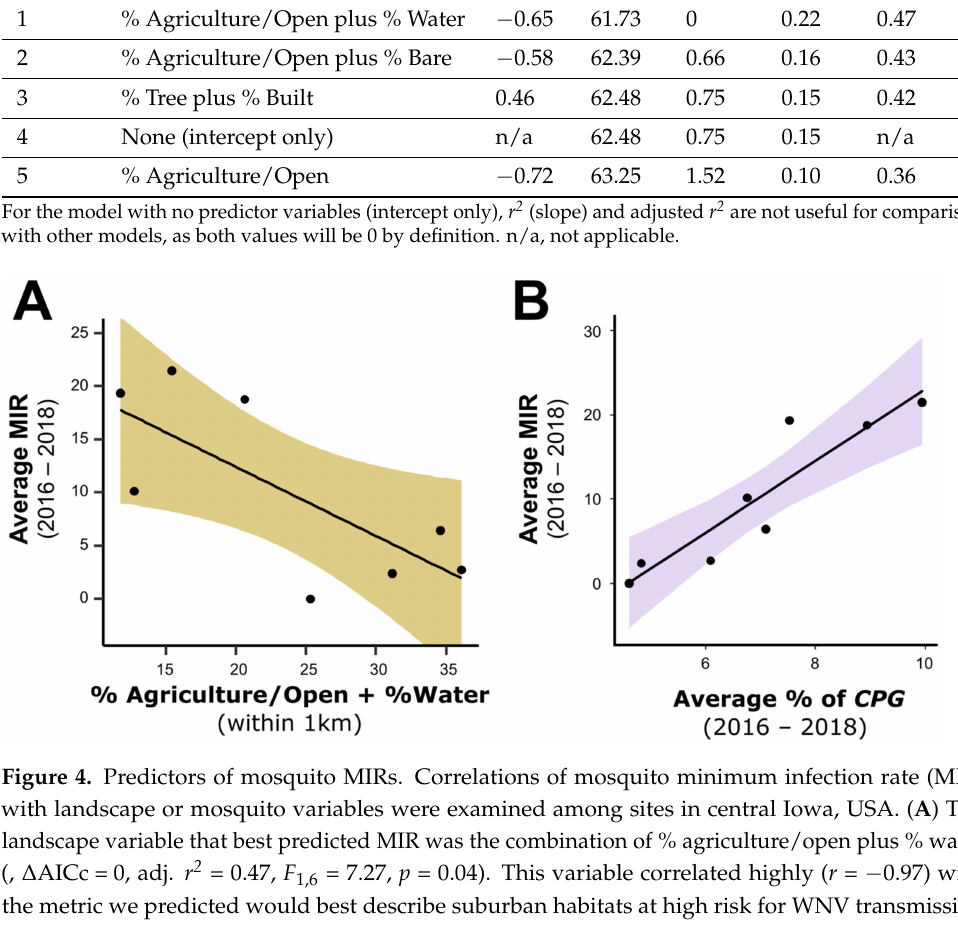
Table 1. Top five models predicting mosquito minimum infection rate (MIR)-based landscape characteristics. Model